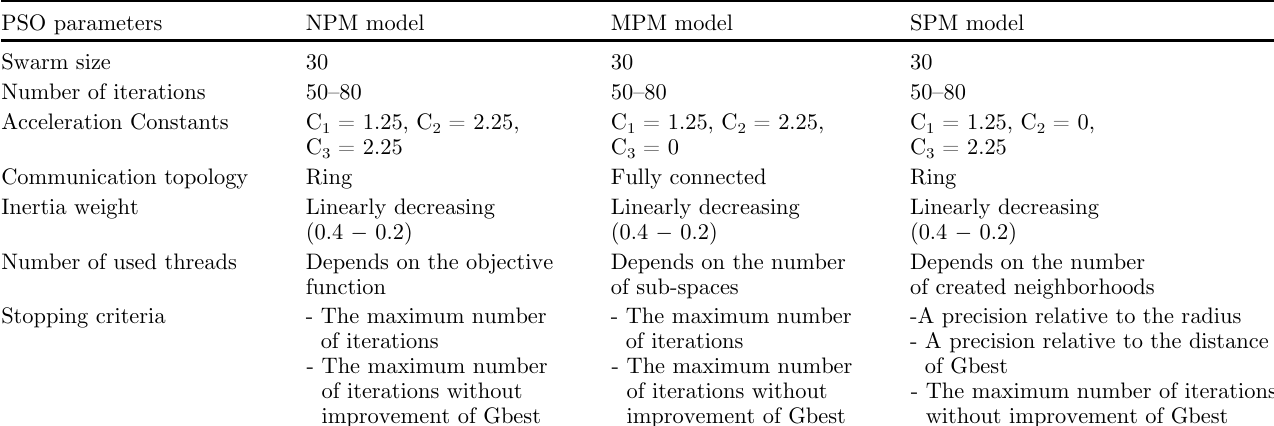
Table 3. Description of the used PSO